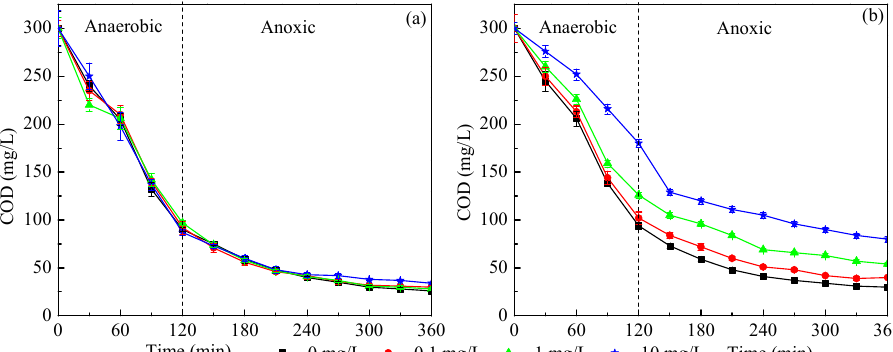
Figure 2. Variations of chemical oxygen demand (COD) in one cycle after 1 day ( a ) and 10 weeks ( b ) of exposure to 0 (black), 0.1 (red), 1 (green), and 10 (blue) mg / L CeO 2 NPs, respectively. Error bars represent standard deviations of triplicate measurement.